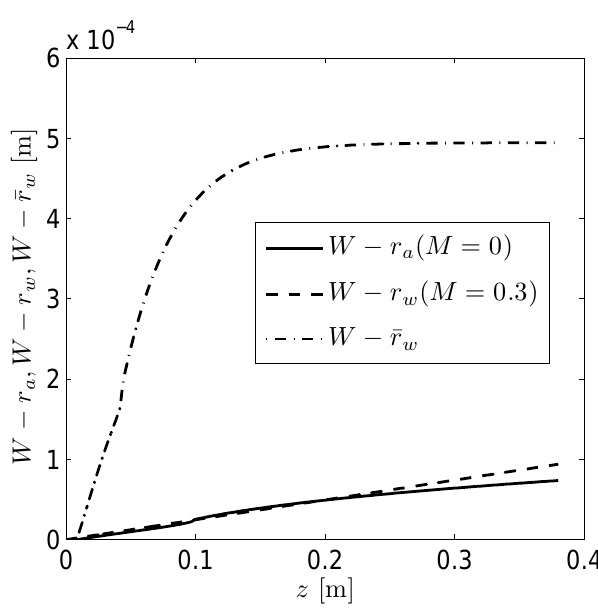
Figure 9. Comparison of the size of the air gap for the untapered system (solid line) with the M = 0.3 linear taper (dotted line), and the ideal taper required to completely eliminate the air gap (dashed